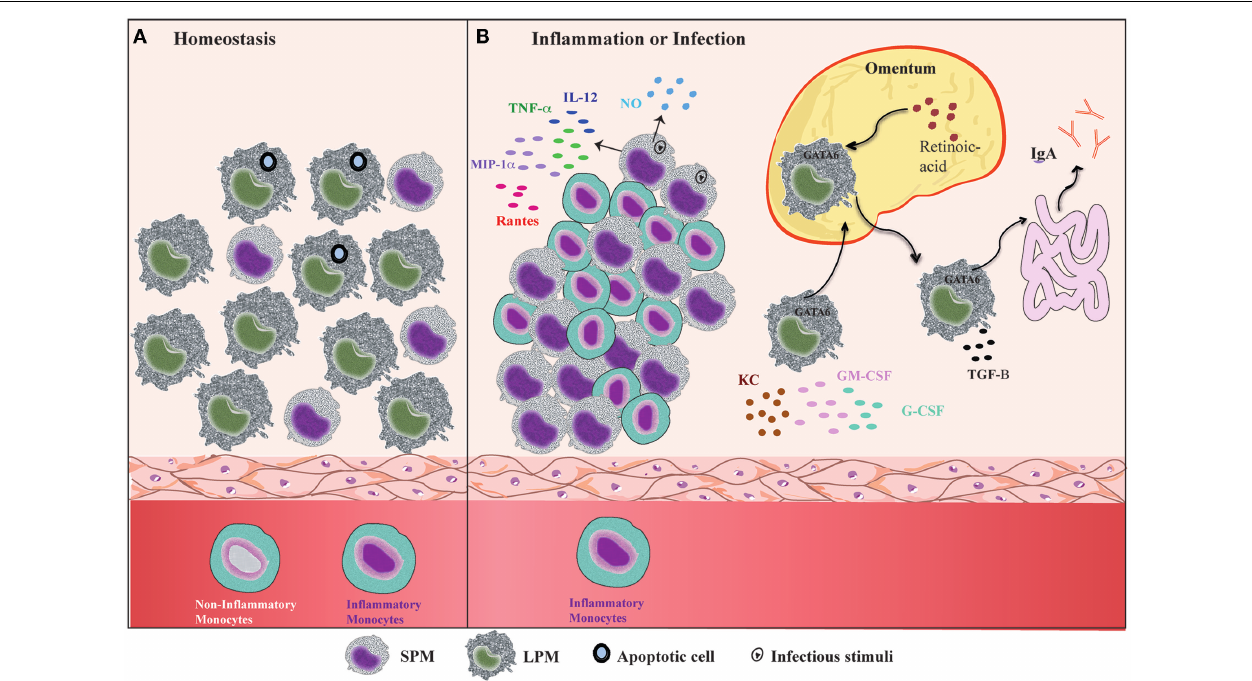
from zymosan and T. cruzi stimulated mice contribute to effector function of PerC through secretion of high levels of NO and presence of IL-12-producing cells (35). In response to LPS in vivo , SPMs produce several inflammatory cytokines, such as IL-12, MIP-1 α , TNF- α , and RANTES, whereas LPMs produce enhanced amounts of G-CSF, GM-CSF, and KC (36). LPMs, which migrate to omentum by a retinoic acid and GATA-6-dependent way in response to in vivo LPS stimulation or vitamin-A deprivation, return to PerC and appear to be correlated with GALT-independent and TGF- β 2-dependent IgA production by B-1 cells in the intestine